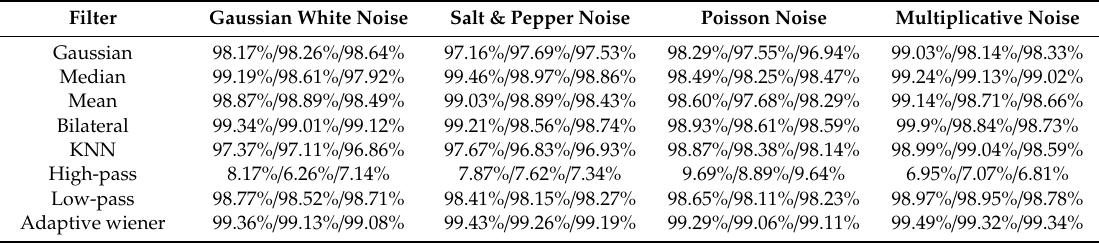
Table 1. The impact on classification of clean images of di ff erent combinations of noise addition and filtering (Inception v4 / Resnet-v2 of 101 / vgg16).